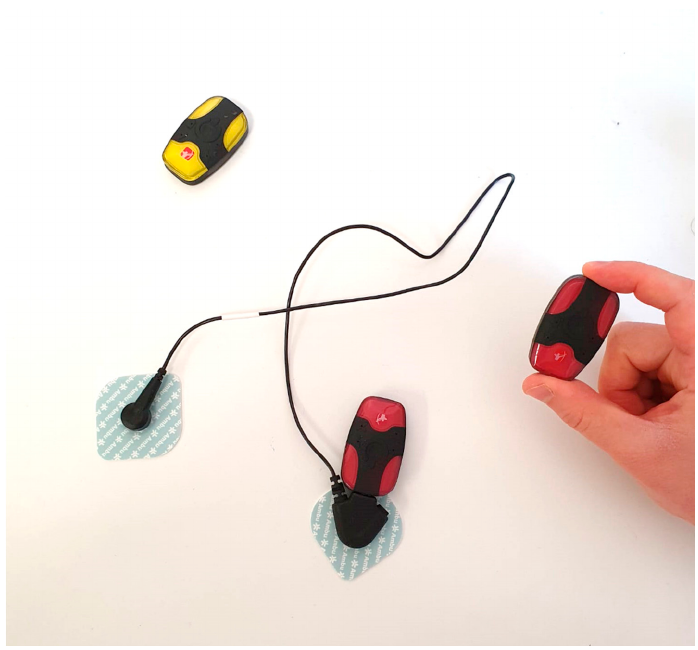
Figure 1. The Bittium Faros TM device.